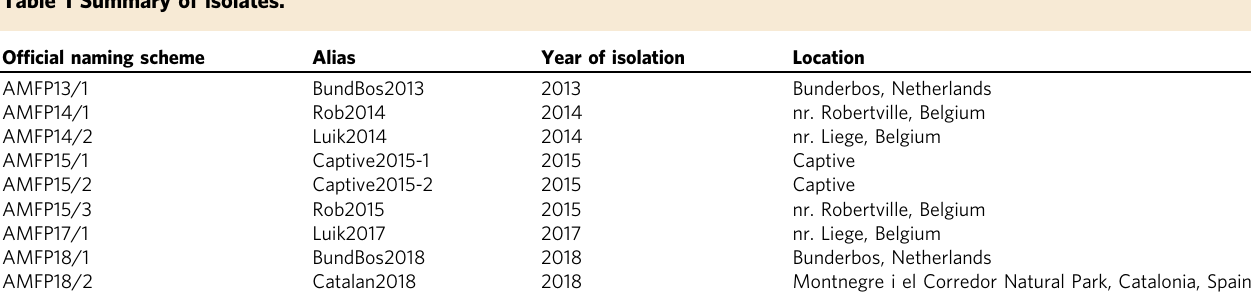
Table 1 Summary of isolates. Of fi cial naming